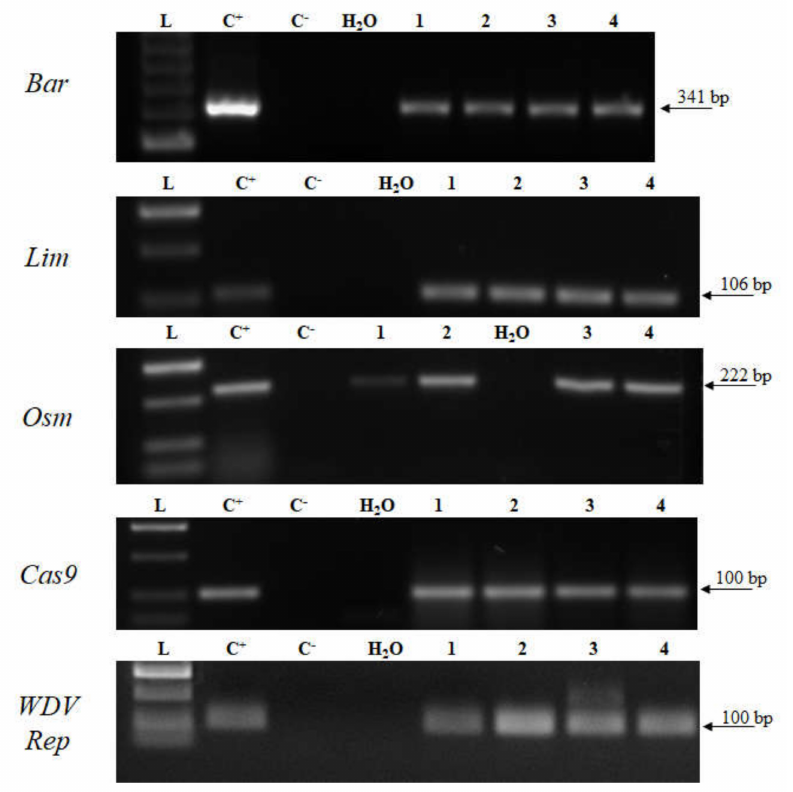
Figure 4. Detection of transcripts in selected DH1 transgenic plants. L—DNA ladder (HyperLadder 50-bp, Bioline); C + —plasmid DNA or transgenic plant; C – —wild-type cDNA sample; 1–4—cDNA samples of DH1 transgenic plants. Bar —barnase; Lim —limen; Osm —osmotin; WDV Rep —replication protein gene; Cas9 —CRISPR associated protein 9.